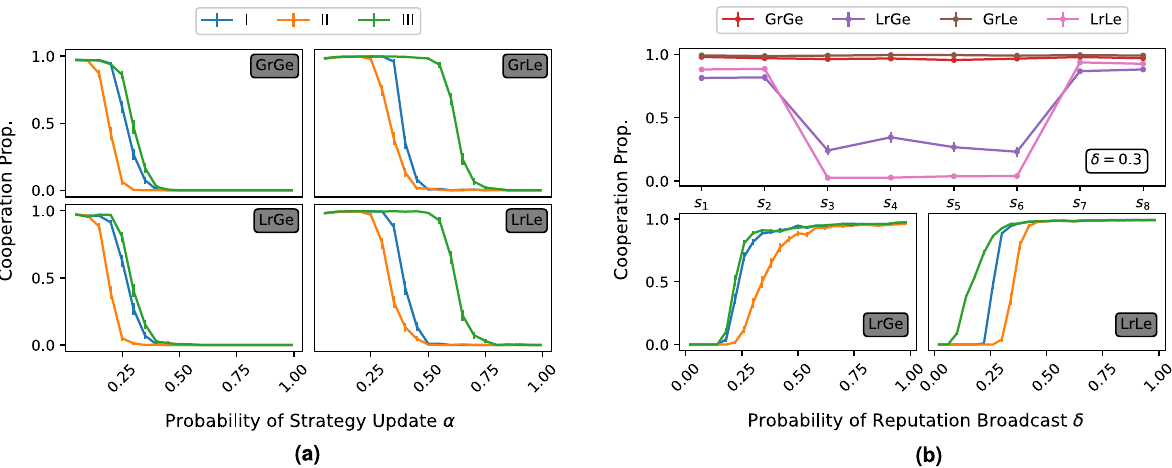
Figure 2. The effect of the speed of evolution and reliability of information on cooperation. ( a ) The quicker the evolution, the greater the domination of unconditional defectors. Under global evolution (left panels) we can clearly see that group II norms require a slower speed of evolution than either groups I or III to resist unconditional defectors. Here, groups I and III display very similar behaviour declining at an almost identical rate. This holds true for both global and local reputation. Under local evolution (right panels), group III norms can maintain cooperation under the widest range of speed of evolution. In all simulations, δ = 1